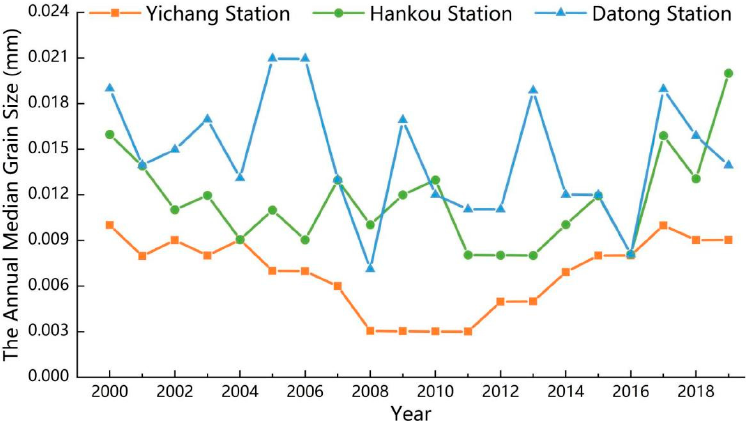
Figure 7. Annual median grain size changes at three hydrological stations from 2000–2019. Water 2023 , 15 , x FOR PEER REVIEW